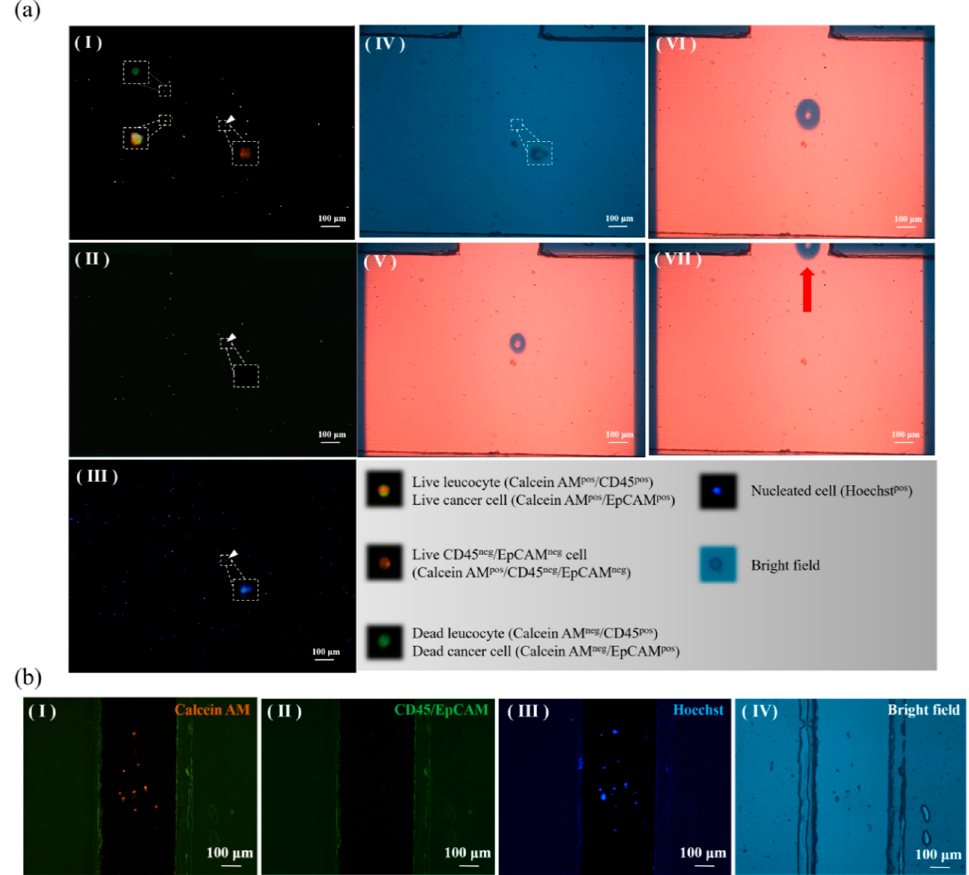
Figure 5. ( a ) Microscopic images showing the isolation of CD45 neg /EpCAM neg cells from the blood sample of head-and-neck cancer patients: (I)–(III) the processes of the fluorescence microscopic observation to identify the CD45 neg /EpCAM neg cells ((I)–(II) the orange colour-only dot image and (III) the blue colour dot image), (IV) the target CD45 neg /EpCAM neg cell was positioned using light field microscopy imaging, (V)–(VII) ODEP-based cell manipulation was carried out to isolate the targeted cells to the side microchannel (a video clip is provided in the supplementary material); ( b ) microscopic observations for evaluating the purity the live CD45 neg /EpCAM neg cells isolated and collected in the side microchannel ((I) calcein AM-positive live cells (orange colour dot images), (II) CD45 surface marker-positive leucocytes, or EpCAM surface marker-positive CTCs (green colour dot images); (III) Hoechst-positive nucleated cells (blue colour dot images); (IV) the cell image obtained using light field